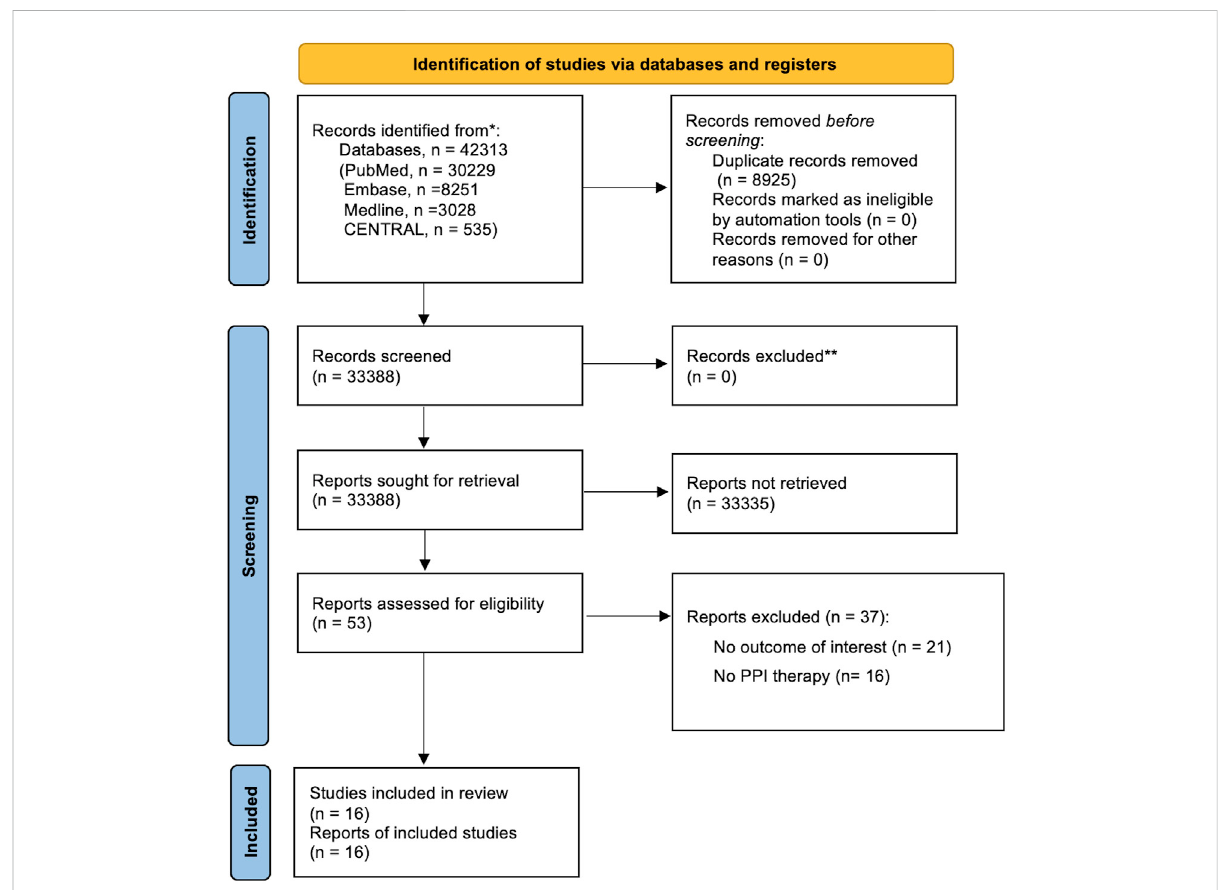
FIGURE 1 PRISMA fl owchart diagram. We initially extracted a total of 42,313 potential references, including 30,229 from PubMed, 8,521 from Embase, 3,028 from Medline, and 535 from CENTRAL. After a duplicate exclusion, 33,388 studies were identi fi ed. Screening the titles and abstracts yielded 53 full-text articles, the eligibility of which was assessed. 37 studies were excluded after reading whole texts owing to reasons elaborated in Supplementary Results S1 in the following section. Eventually, 16 studies ful fi lled the eligibility criteria and were included for qualitative and quantitative syntheses. PRISMA, Preferred Reporting Items for Systematic Reviews and